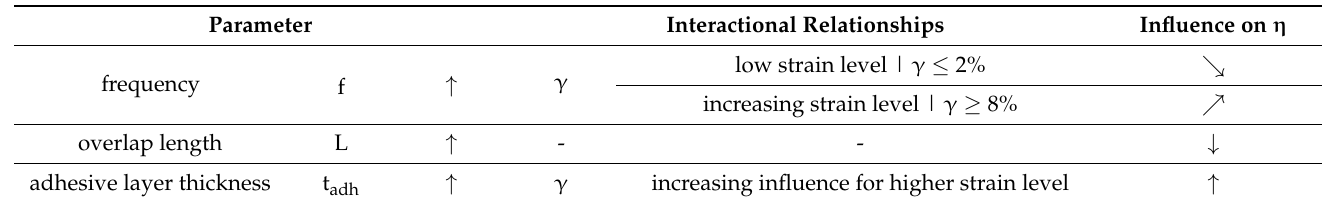
Table 5. Influence and interactional relationships of the investigated parameters on the loss factor of adhesively bonded overlap joints. Interactional